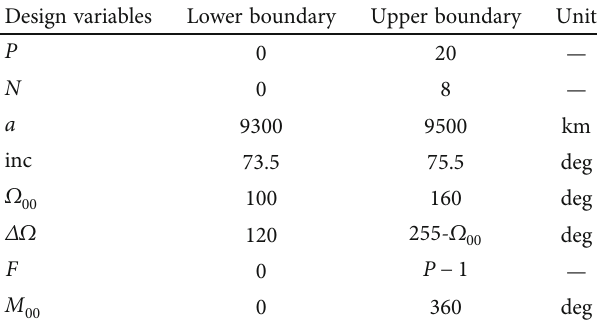
Figure 6: 77-satellite Walker constellation, which is the result for the optimization model with discrete object. (a) View from azimuth = 160 ° and elevation = 45 ° ; (b) view from azimuth = 110 ° and elevation = 90 ° . Table 4: Constraints on the design